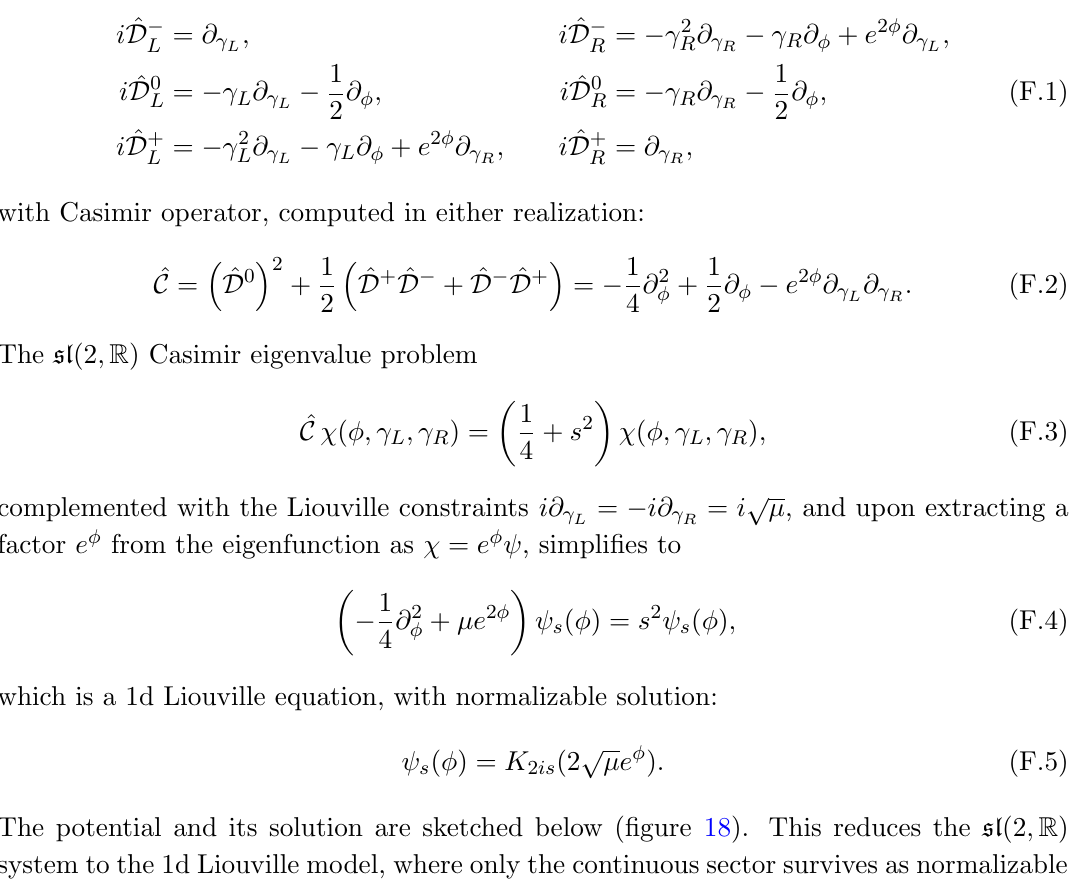
Figure 18 . 1d Liouville potential (red), with normalizable solution s ( (cid:30) ) superimposed (blue). F From the sl (2 ; R ) Casimir to the minisuperspace Liouville Hamiltonian To the Gauss parametrization (E.16), one can associate the left- and right-regular realiza- tion of the